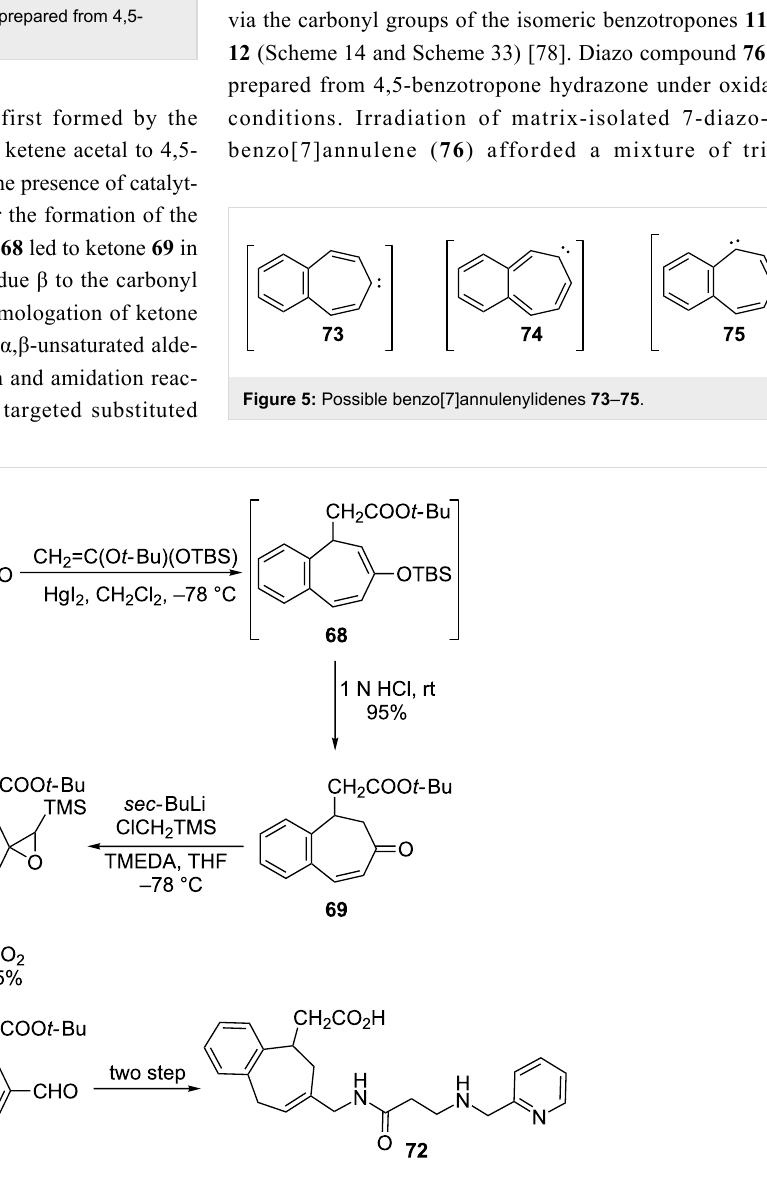
Scheme 13: Preparation of substituted benzo[7]annulene 72 using the Mukaiyama-Michael reaction.